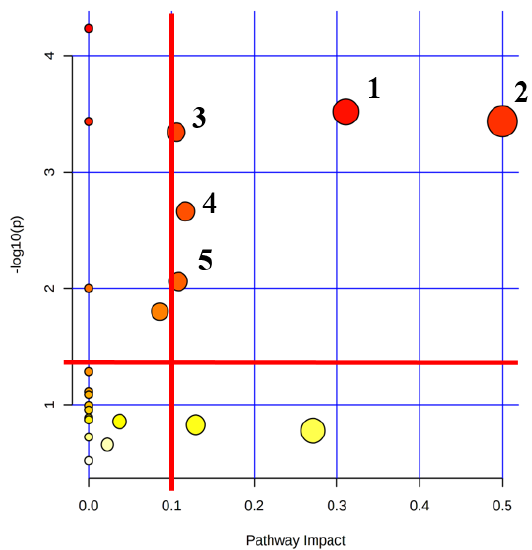
Figure 7. The metabolic pathway analysis of lactate-treated myoblasts relative to controls. Five significantly altered metabolic pathways were identified with two criteria of pathway impact values > 0.1 and p values < 0.05 (i.e., − log10( p ) > 1.3), including (1) alanine, aspartate and glutamate